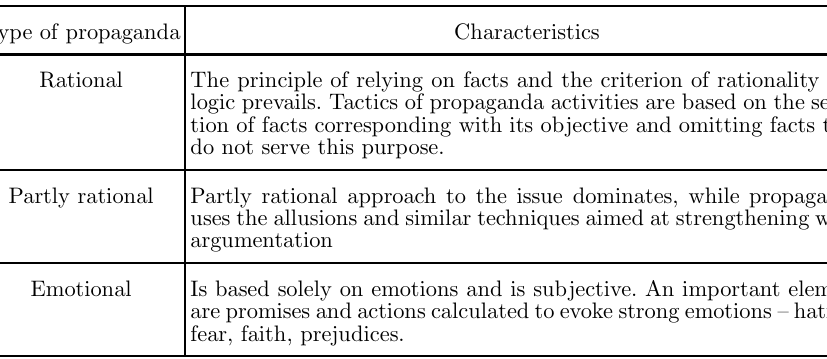
Figure 1. Thomson’s propaganda types Type of propaganda